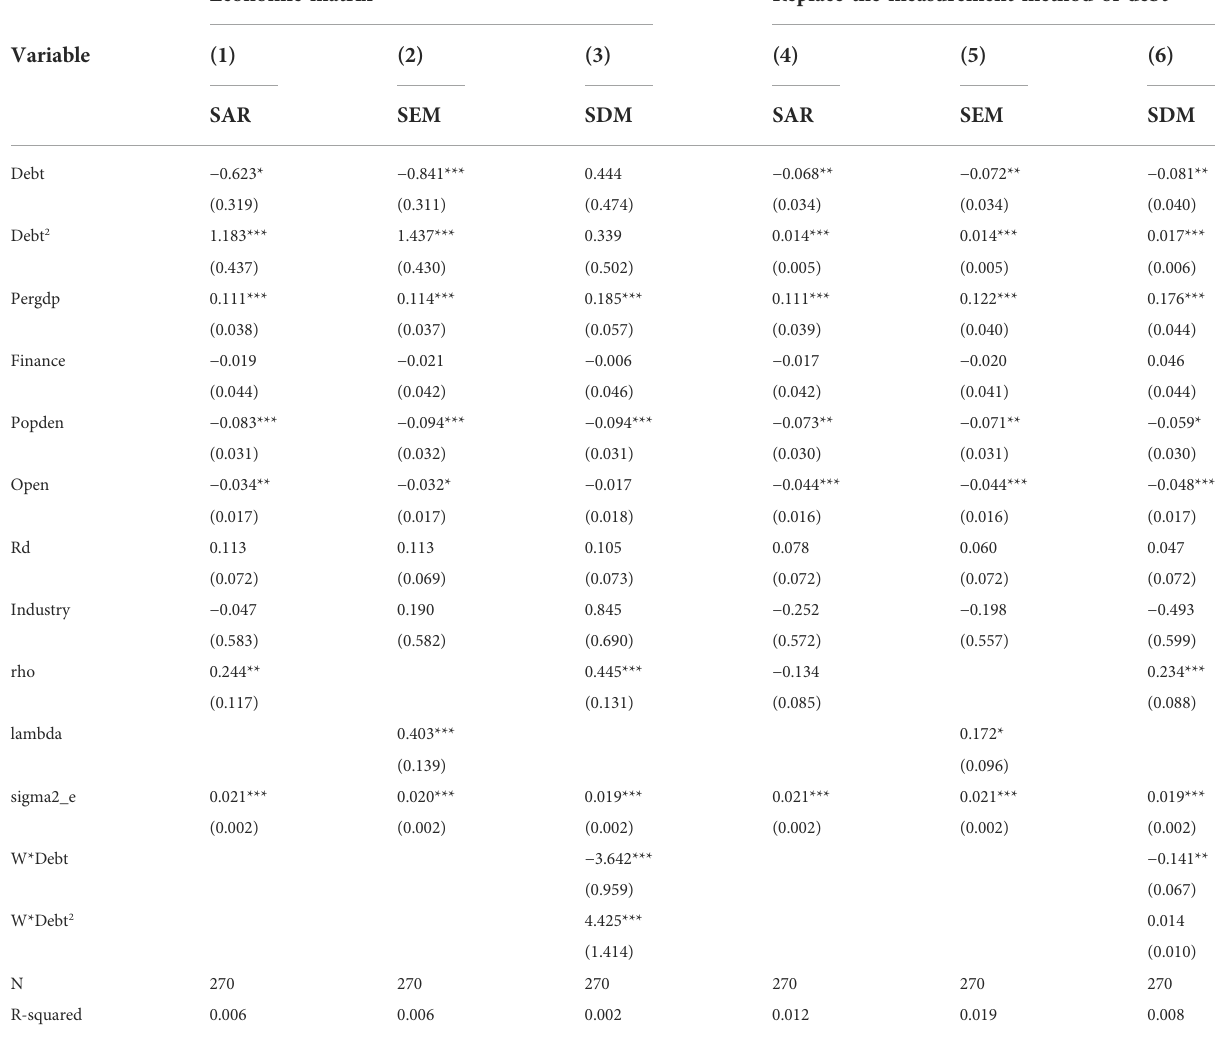
TABLE 6 Robustness test of the spatial econometric models. Economic matrix Replace the measurement method of debt